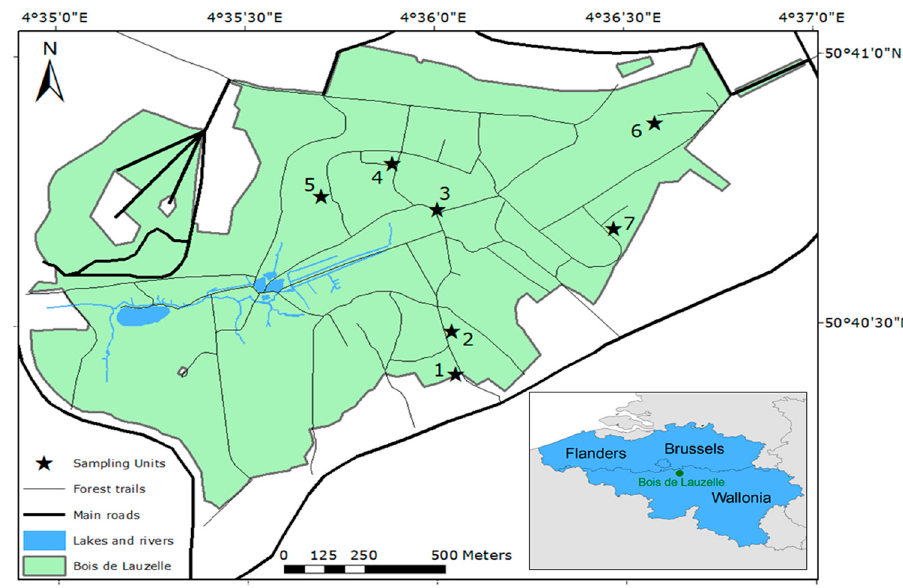
Figure 1. Location of the seven sampling sites in the Bois de Lauzelle. Seven sites were selected for sampling (Figure 1). In each site, we sampled 1 transect of 10 m with a 1 m × 1 m white flannel. The mean distance between two sites is 632 m (range: 146–1080 m). These sites presented diverse characteristics of the forest (Table 1). The western part of the forest was not accessible. Site 1 was at an entrance of the forest, close to a cub scout’s meeting place. The transect was located on a loamy soil